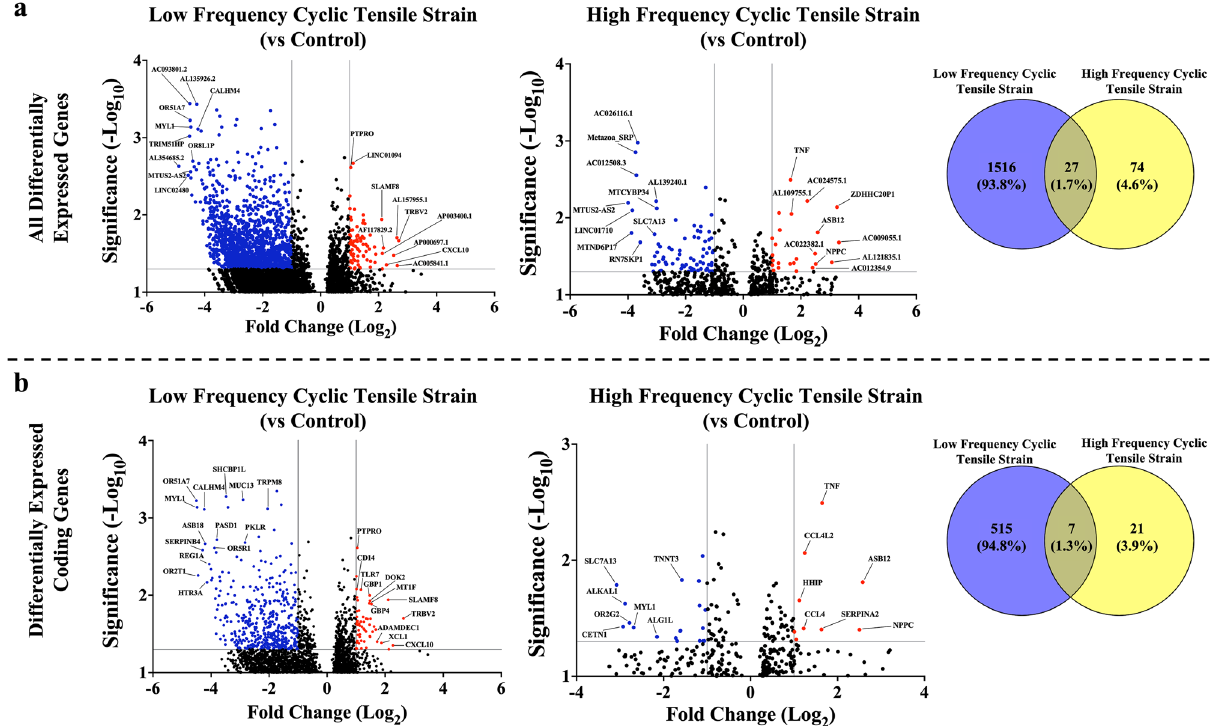
Figure 1. Differentially expressed genes in Low- and High-frequency tensile strain conditions (versus Control). ( a ) All differentially expressed genes and ( b ) differentially expressed coding genes. Each panel contains volcano plots displaying the top differentially expressed genes for low frequency cyclic tensile strain (vs control) and high frequency cyclic tensile strain (vs control). The Y-axis represents the − log10 p-value cut-off set at 1.3 (p-value < 0.05) and the X-axis represents the log2 fold change cut-off of below − 1.0 (blue) or above 1.0 (red). Venn diagrams display the number of differentially expressed genes in common and unique to Low and High- frequency tensile strain Of the 522 coding genes that were differentially expressed following low-frequency tensile strain (vs. control), 467 coding genes decreased, and 55 genes increased (Fig. 1b). Genes involved in circadian rhythm ( PASD1 ), cell metabolism ( CALHM4 , PKLR, G6PC2 ), pain signaling ( TRPM8, HTR3A), innate immunity (REG1A, ASB18 ), and the olfactory receptor gene family ( OR51A7, OR5R1, OR2T1 ) were decreased, whereas genes involved in